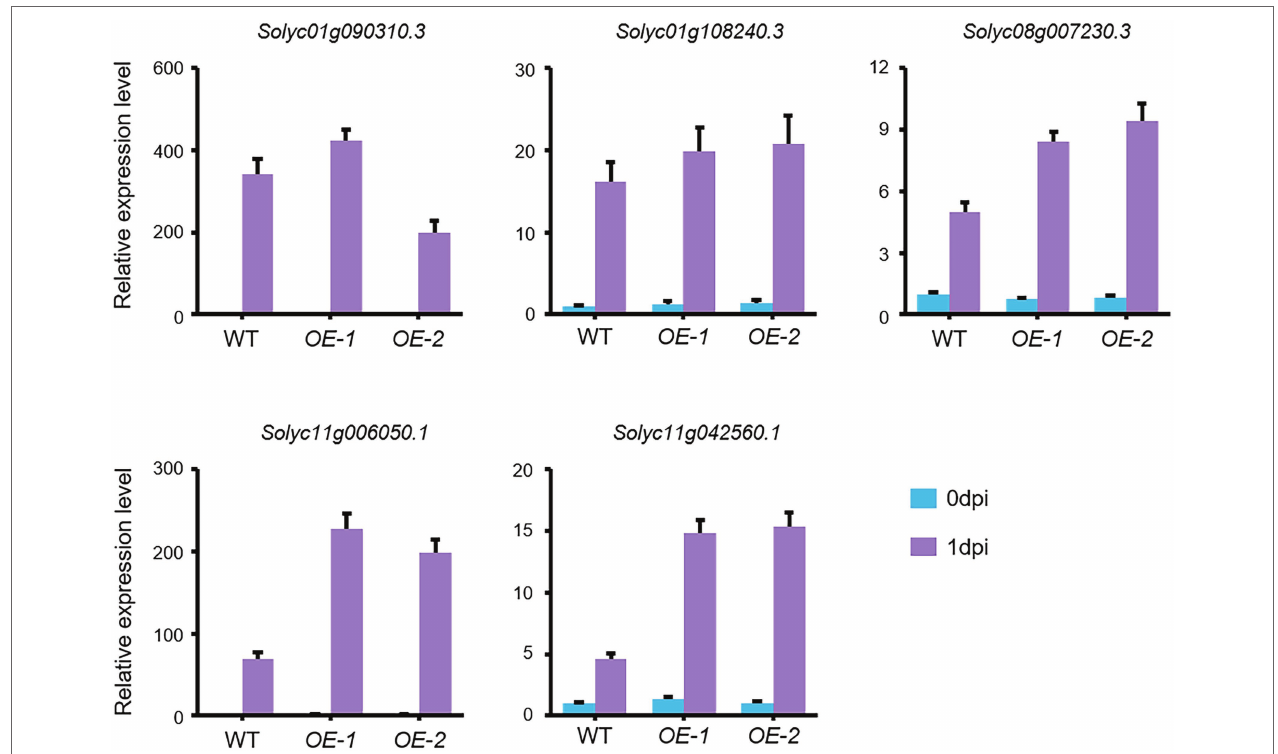
FIGURE 7 | FORL -Induced ERF Expression in SlLecRK1- OE plants. The expression of five ERF genes in WT, OE-1 , and OE-2 plants before (0 dpi) and after (1 dpi) FORL inoculation is shown. Total RNA was used for qRT-PCR analysis. eEF1 α served as a reference. The WT values at 0 dpi were set to 1. Data are shown as the mean ± SD from three biological